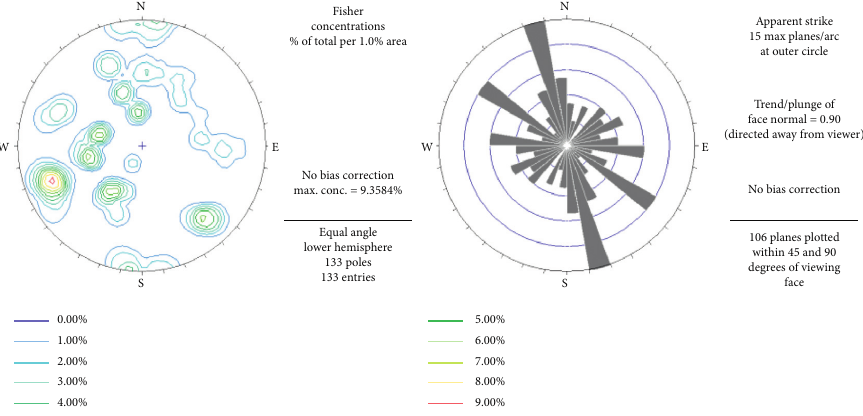
Figure 6: Dominant joint sets in the drifts between #115 and #159 exploration sections. Table 1: Physical and mechanical properties of the phyllic granitic cataclasite in